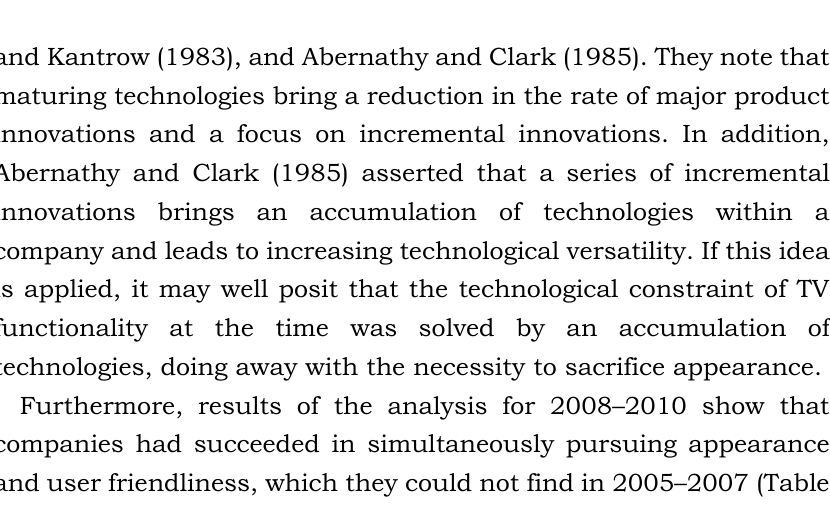
Table 4. Cross tabulation between appearance and user friendliness from 2008 to 2010 User friendliness Total Low High Low 76 21 97 Appearance High 61 35 96 Total 137 56